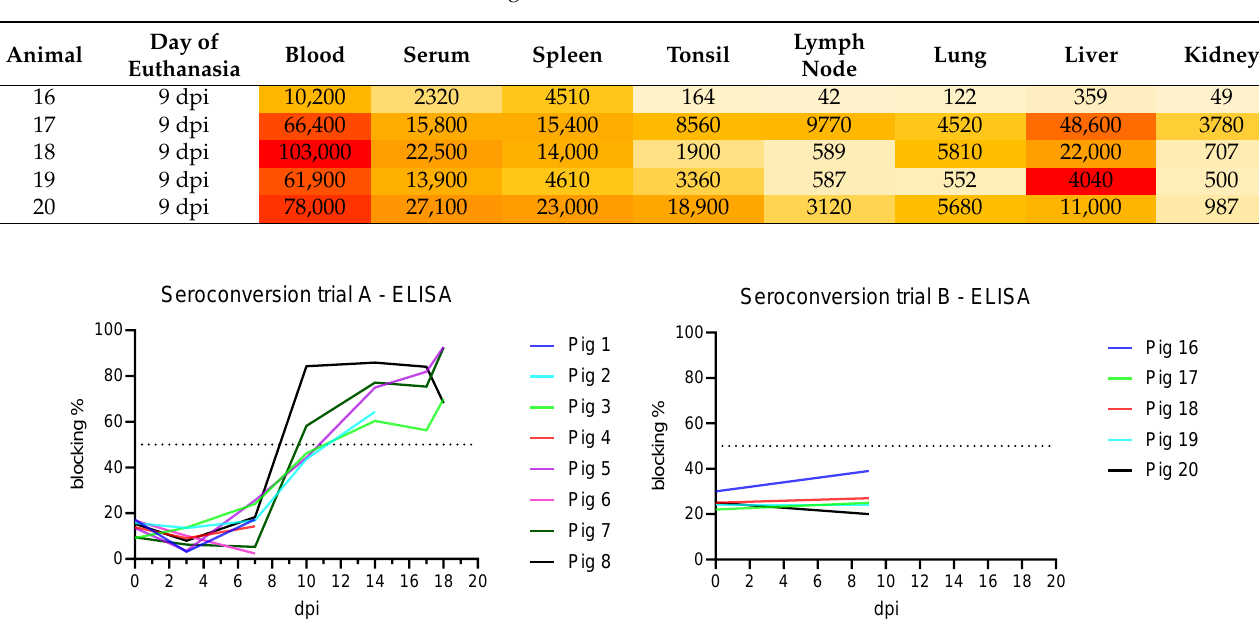
Figure 4. Seroconversion of the subadult animals from trial A detected on 10 dpi with INGEZIM PPA COMPAC ELISA (Ingenasa, Madrid, Spain). Weaner pigs from trial B showed no ELISA detectible seroconversion at 9 dpi. The ELISA cutoff is 50% blocking which is indicated as a dotted line in both graphs.